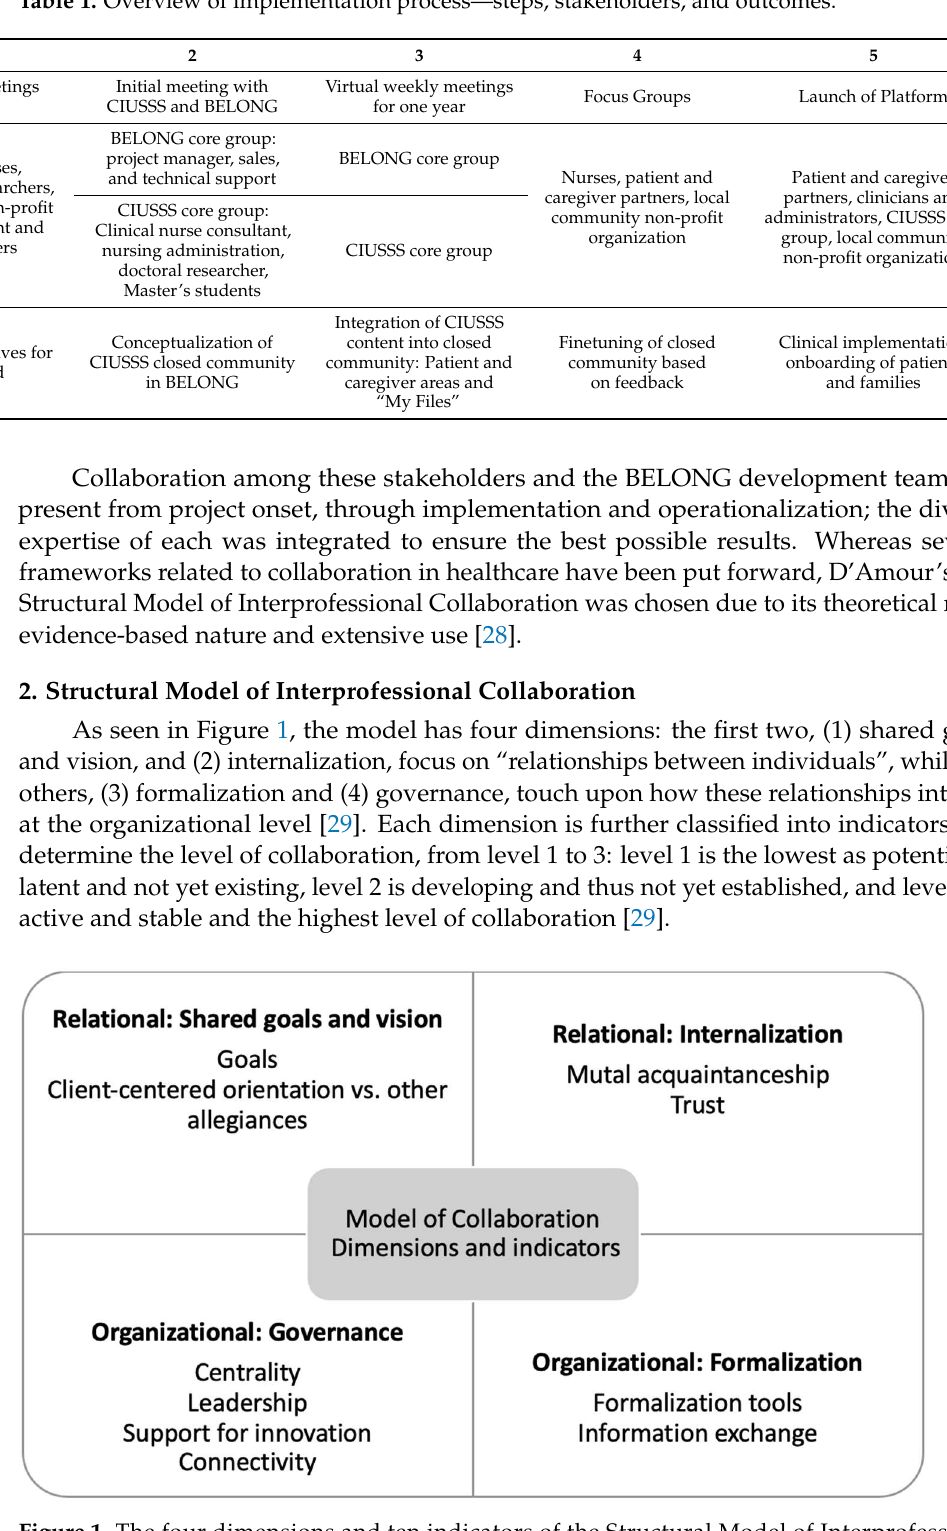
Figure 1. The four dimensions and ten indicators of the Structural Model of Interprofessional Collaboration